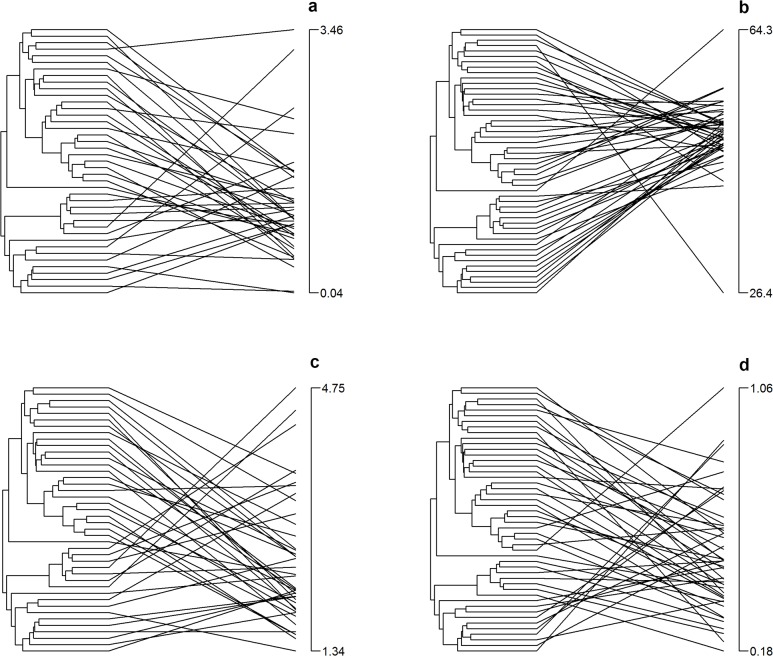
Traitgrams indicating the relationship between each species' trait value (vertical axis on the right of each panel), and its phylogenetic position on the left.
a) Distribution of I* across the phylogeny. For this trait a WN model was supported, indicating a random distribution of traits across the phylogeny; b) Distribution of % C across the phylogeny, a WN model was supported, again indicating a random trait distribution; c) Distribution of log-transformed algal biovolume across the phylogeny, a δ model was supported with a δ value of 7.971, suggesting a very weak influence of ancestral branches on trait variation; and d) Distribution of % P across the phylogeny, a λ model was supported with a λ value of 0.171, indicating that a tree-transformation to a nearly star-like phylogeny was the best fit. The phylogeny in this figure is the phylogeny published in Alexandrou et al. 2015 [49]. We have smoothed the branches of the phylogeny only for purposes of the illustration.